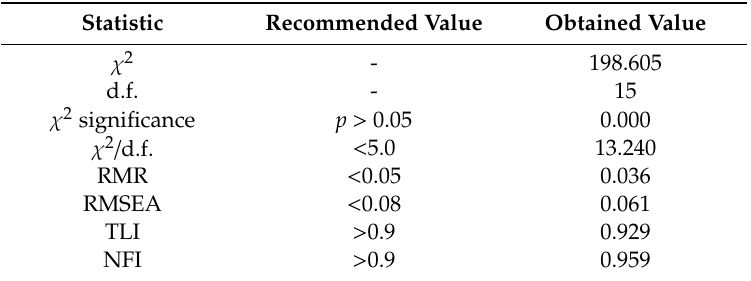
Table 4. Model Fit Indices with Recommended Values ( n =